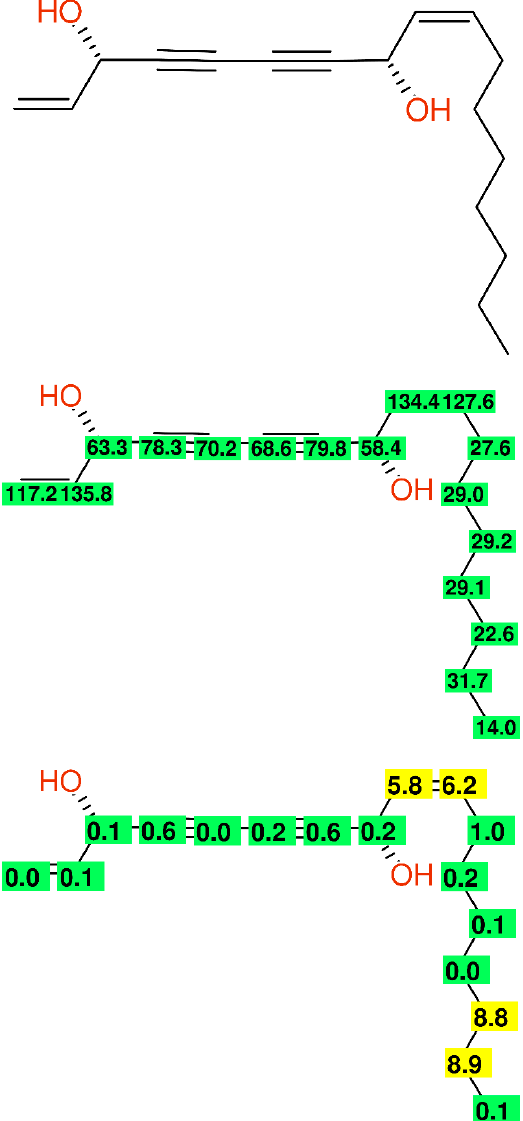
Figure 9. Compound OH-1 from [52] as another example of a misassigned alkyl chain. Experimental chemical shift values ( middle ) and the differences between the experimental and predicted chemical shift values ( bottom ).